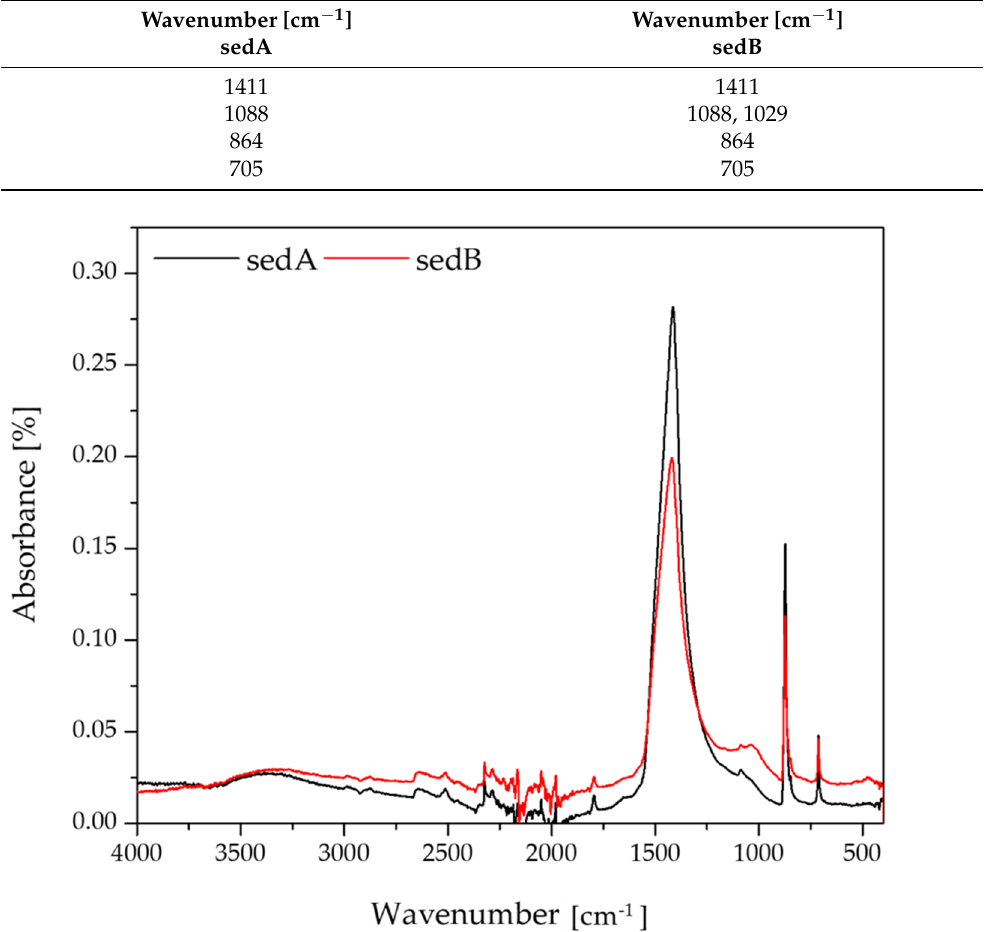
Table 3. Summary of the wavelengths in the FTIR analysis of bottom sediment samples .